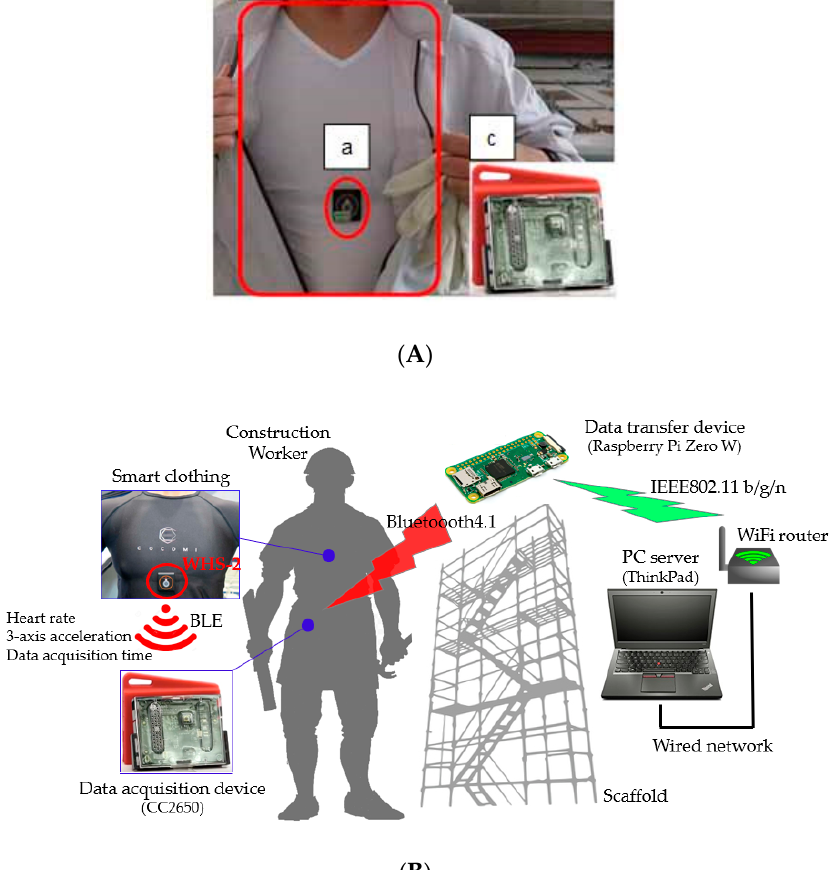
Figure 1. Picture of measurement equipment for physiology in this study. ( A ) a: Heart rate and acceleration sampling sensor (WHS-2), b: smart clothing (COCOMI), c: data acquisition device (CC2650); ( B ) System configuration for physiology in this study.